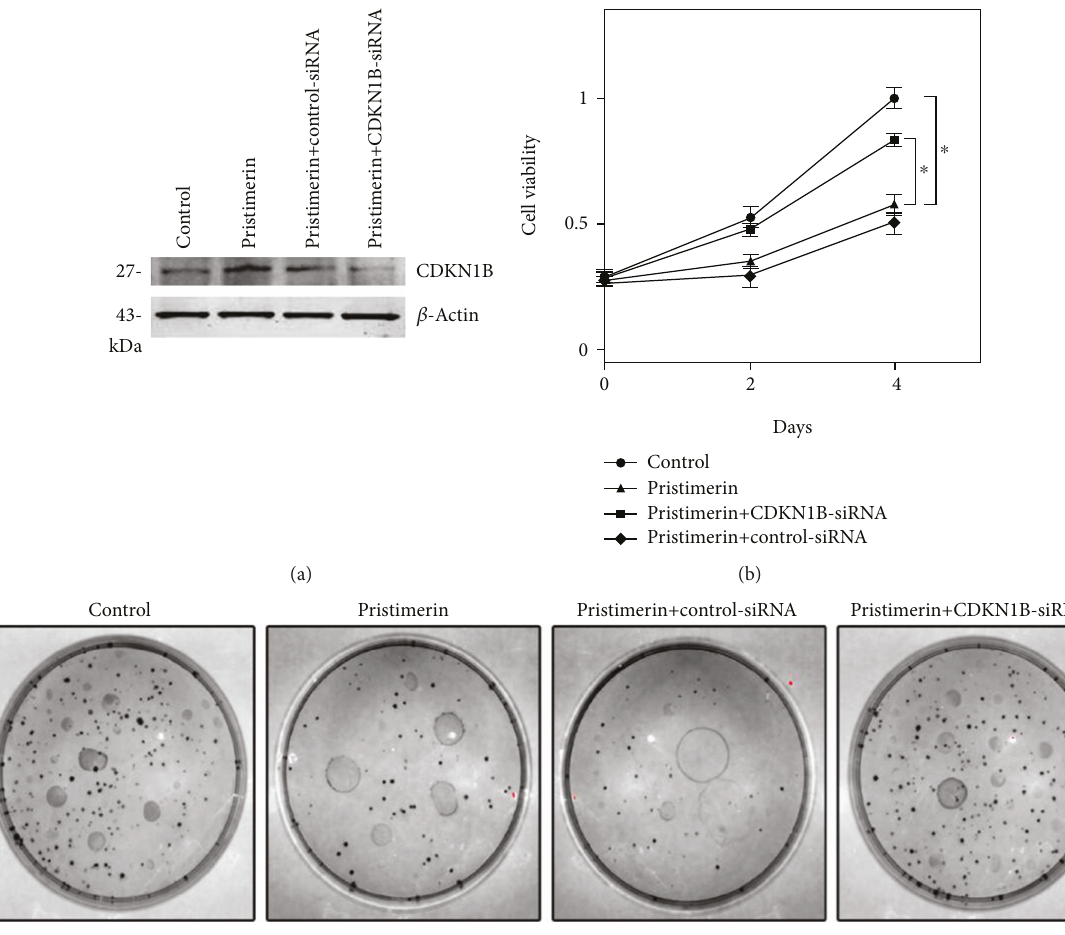
Figure 4: Enforced CDKN1B expression partially reversed the e ff ects of pristimerin in Eca109 cells. (a) Cotransfection of the CDKN1B vector successfully restored CDKN1B expression in Eca109 cells. (b) Exogenous expression of CDKN1B reversed Eca109 cell viability inhibition induced by pristimerin. (c) Exogenous expression of CDKN1B reversed colony formation capability reduction induced by pristimerin. ∗ P < 0 05 versus control group ( n = 3 independent experiments for each